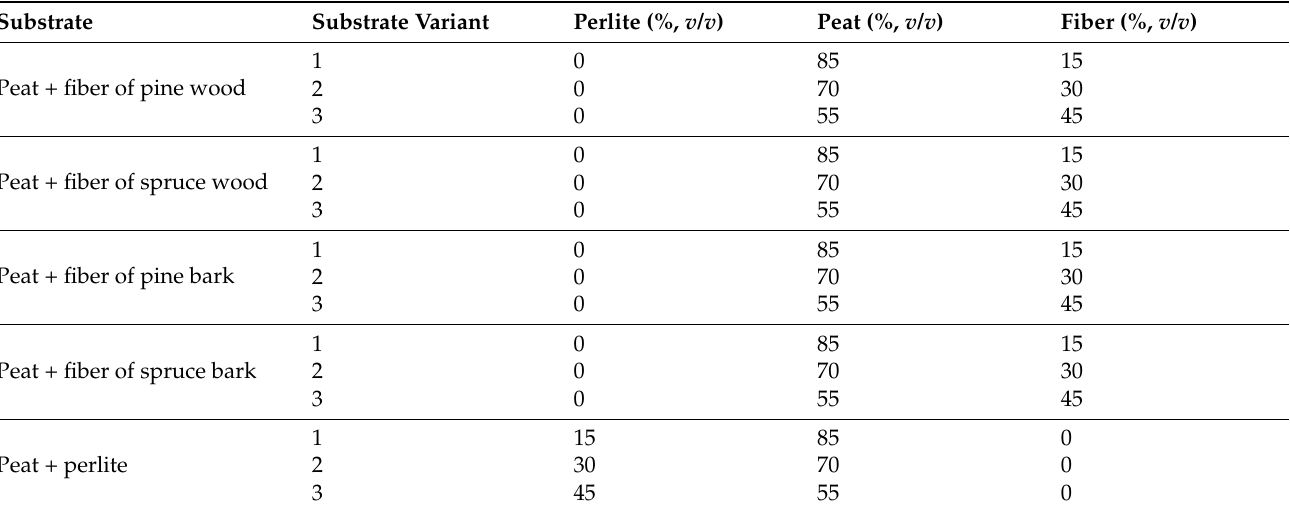
Table 1. Composition of the substrates.